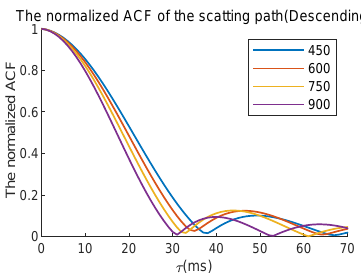
Figure 8. The normalized ACFs of the scattering path (Descending).